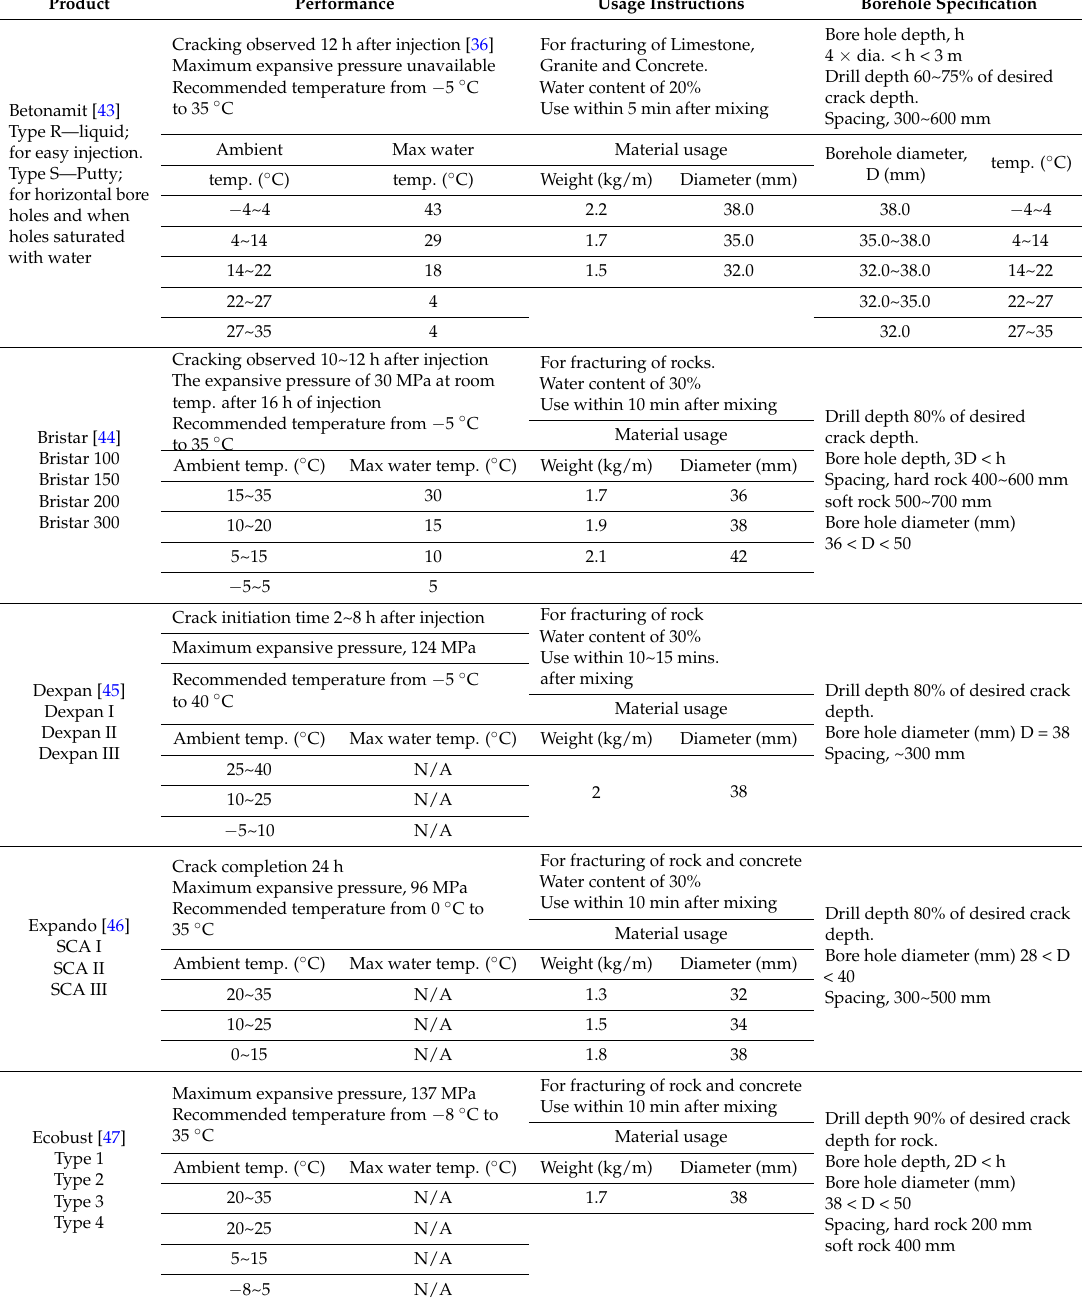
Table 1. Types of commercially available